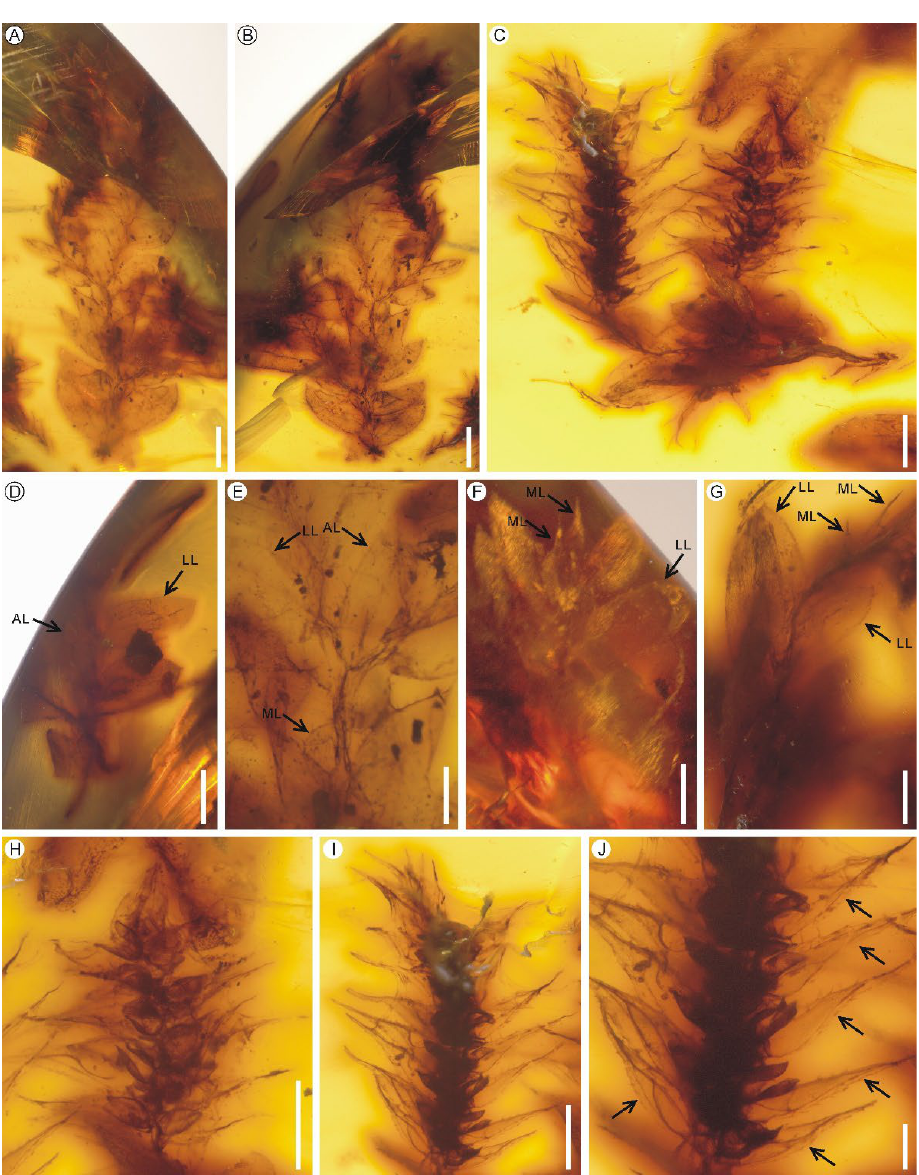
Figure 5. Accompanying Selaginella alata sp. nov. from the mid-Cretaceous Kachin amber. ( A , B ) A fertile shoot in dorsal and ventral views. PB200746a. Scale bars = 1 mm. ( C ) Another fertile shoot. PB200746b. Scale bar = 500 μm. ( D ) A sterile shoot showing the axillary leaf (AL). PB200745a. Scale bar = 1 mm. ( E , F ) Magnifications of the shoot showing the axillary, median and lateral vegetative leaves (AL, ML and LL). PB200746a. Scale bar = 500 μm. ( G ) Magnifications of the shoot showing the median and lateral vegetative leaves. PB200746b. Scale bar = 300 μm. ( H , I ) Strobili PB200746b. Scale bar = 500 μm. ( J ) Magnification of the strobilus ( I ) showing the alary serrulate keel (black arrows) on the abaxial side of the midrib of sporophylls. PB200746b. Scale bars = 200 μm.